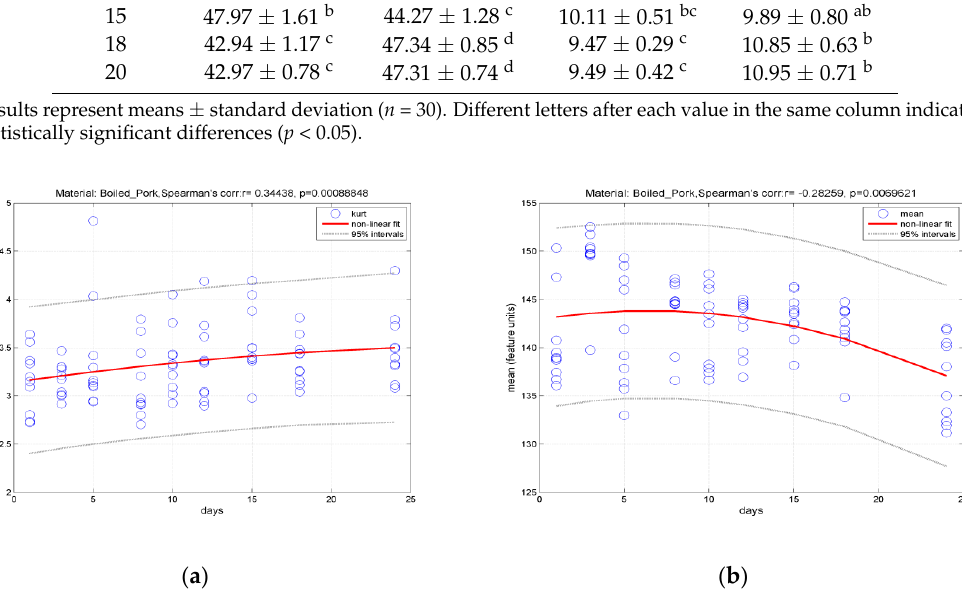
Figure A1. Variation of features ( a ) kurtosis and ( b ) mean intensity value of boiled pork hams during refrigerator storage.